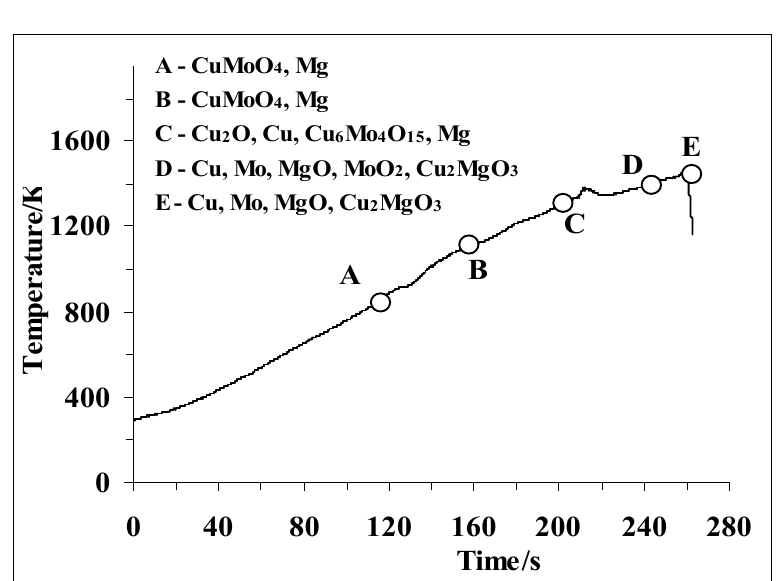
Figure 9. The heating thermogram of the CuMoO 4 + 4Mg mixture with the XRD analysis results of the quenched samples at different characteristic temperatures, A—T = 923, B—1123, C—1323, D—1413, E—1573 K, V h = 300 K min − 1 .